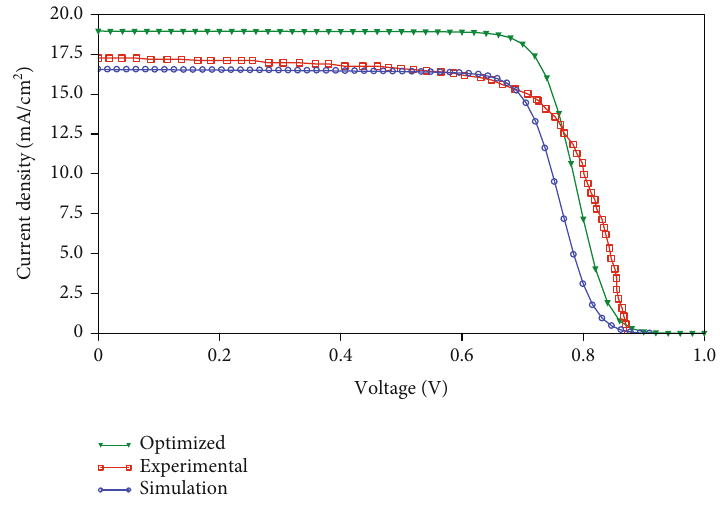
Figure 7: Experimental, simulated, and optimized J-V characteristics of the a-Si:H solar cell. Table 4: Comparison of the electrical parameters of the experimental and optimized solar cell